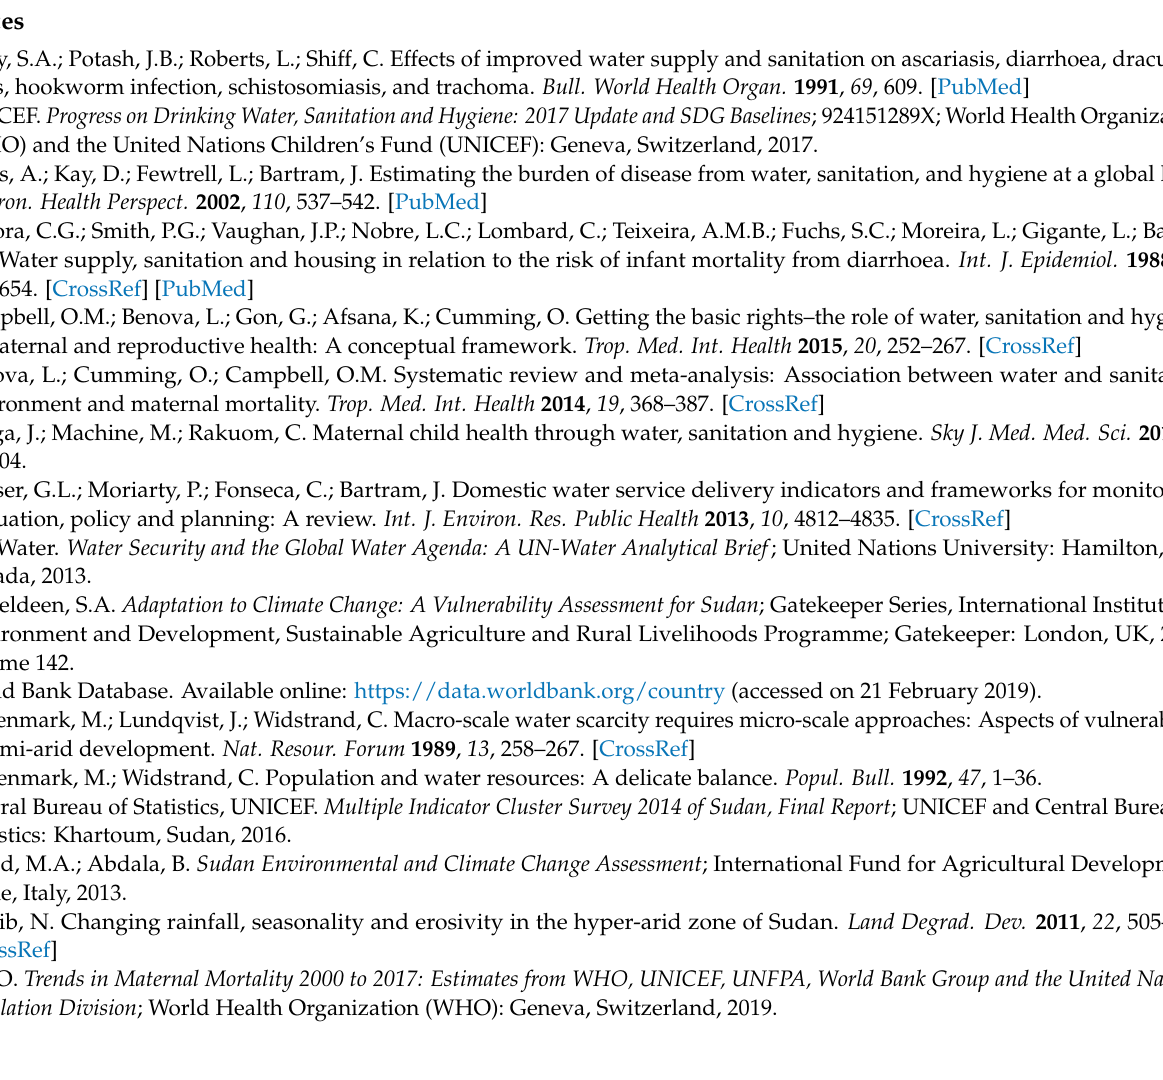
precipitation. Figure S9: Interpolation of historical and future water balance ratio calculated with annual precipitation and evapotranspiration. Figure S10: Standard deviation in the future DWSI over the values obtained by running the five different global circulation models. Figure S11: Future DWSI at health facility level with the uncertainty range of the future DWSI. Table S1: Source, type, format, resolution, and year of each input dataset; Table S2: Population and water supply statistics at state level. References [52–73] are cited in the supplementary